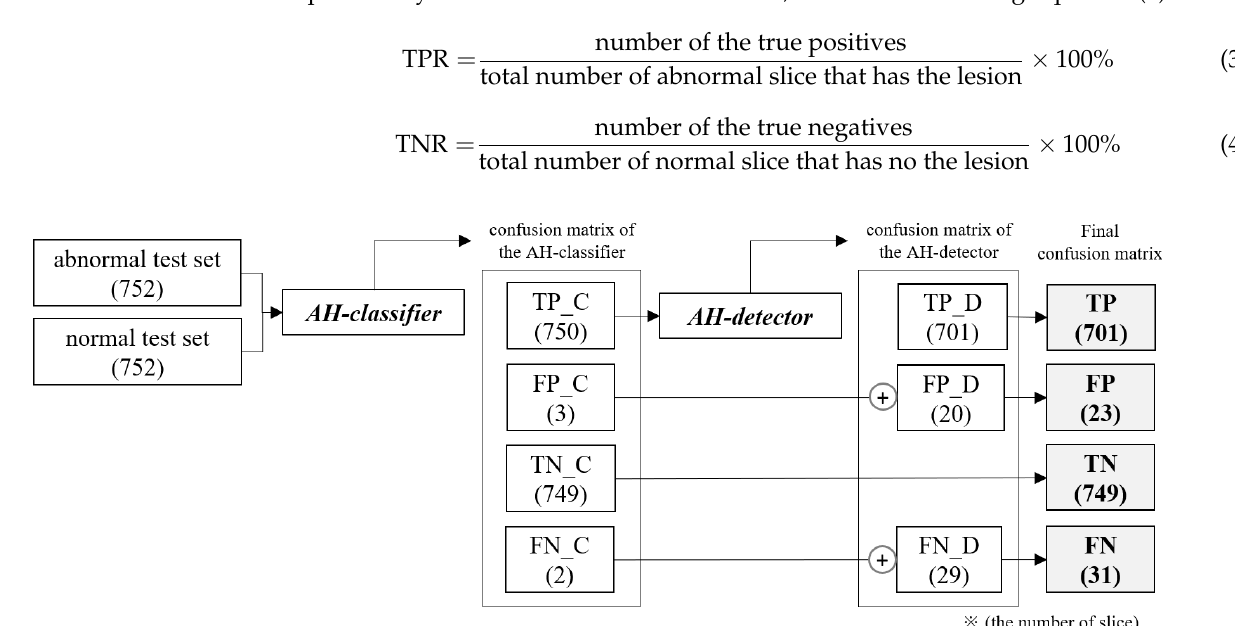
Table 5. The confusion matrix for the AH classifier.